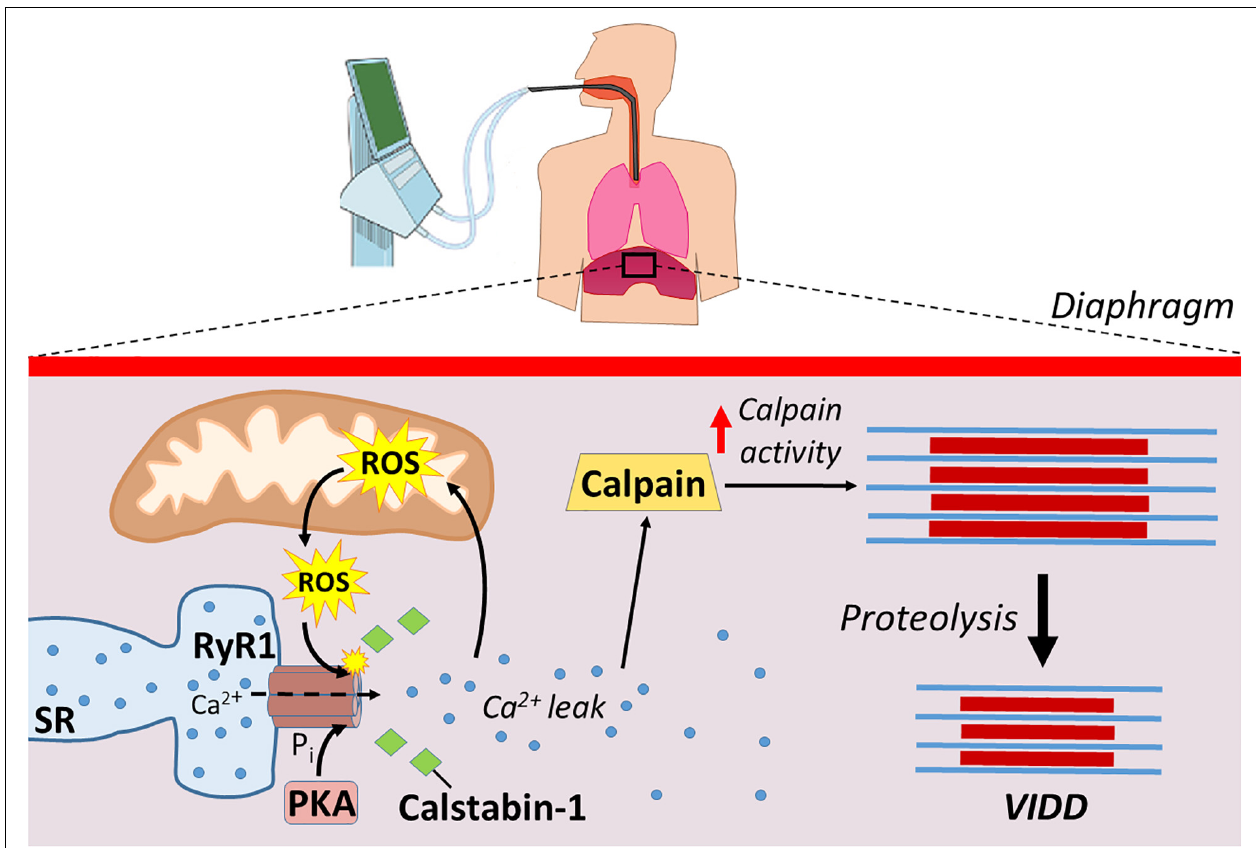
FIGURE 3 | Mechanical ventilation causes Ca 2 + disruptions that lead to increased proteolysis. ROS production from mitochondria, along with increased protein kinase A (PKA) activity, modify ryanodine receptors (RyR1) leading to the disassociation of calstabin-1. Disassociation of calstabin-1 from RyR1 leads to Ca 2 + leak, activation of calpains, and increased proteolysis that contributes to